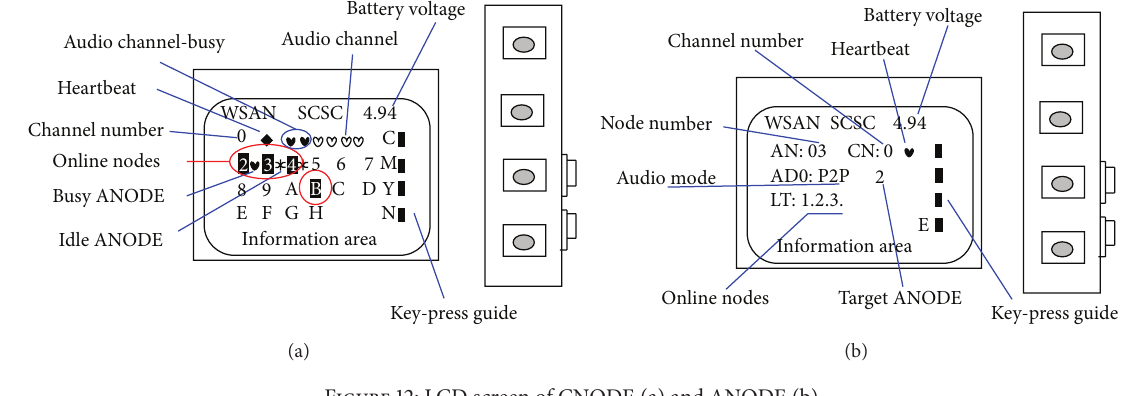
Figure 12: LCD screen of CNODE (a) and ANODE (b).